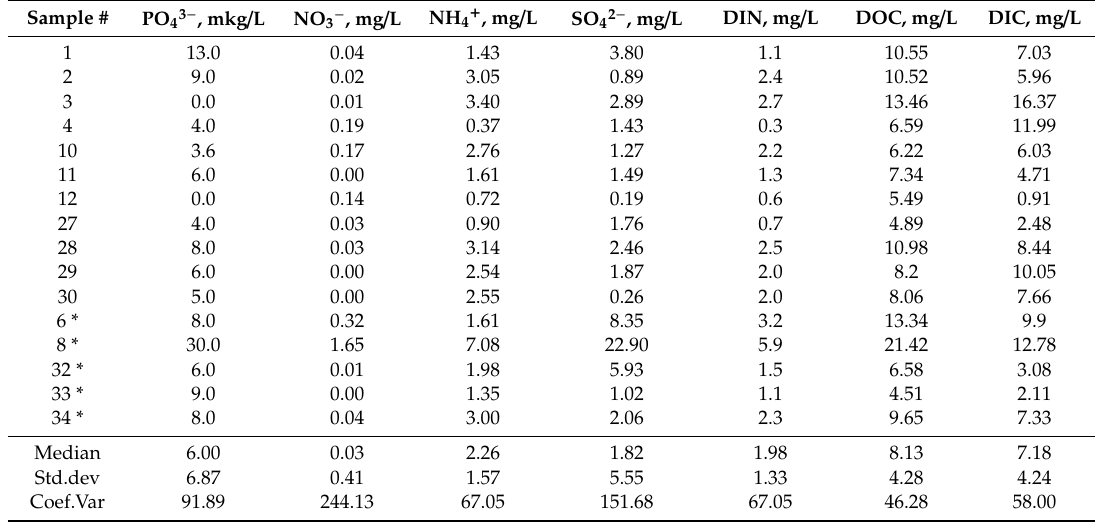
Table 4. Ground ice thaw water solutes concentration and bulk biogeochemical